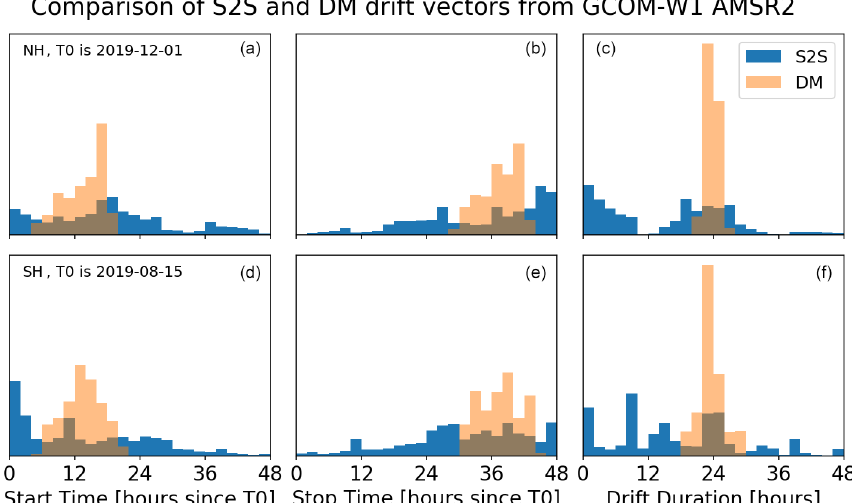
Figure 4. Distribution of S2S (blue) and DM (orange) vectors derived from GCOM-W1 AMSR2 imagery in the Northern Hemisphere (a–c) and Southern Hemisphere (d–f) : start time (a, d) , end time (b, e) and duration of the drift vectors (c, f) . Table 2. Statistics from the validation of DM and S2S vectors derived from GCOM-W1 AMSR2 Ka-band imagery in the Northern Hemi- sphere (NH) and Southern Hemisphere (SH) against on-ice buoy trajectories. Biases ( µ ) and RMSE ( σ ) in d X and d Y components of the drift vectors are reported in kilometres (km), and N is the number of matchup pairs. Only vectors with a duration of 24 ± 2h are validated. NH SH µ d X µ d Y σ d X σ d Y N µ d X µ d Y σ d X σ d Y N DM − 0.09 + 0 . 01 1.36 1.32 2153 − 0.29 + 0 . 46 2.29 2.91 509 S2S − 0.06 − 0.02 0.91 0.92 21245 − 0.04 + 0 . 20 1.36 1.62